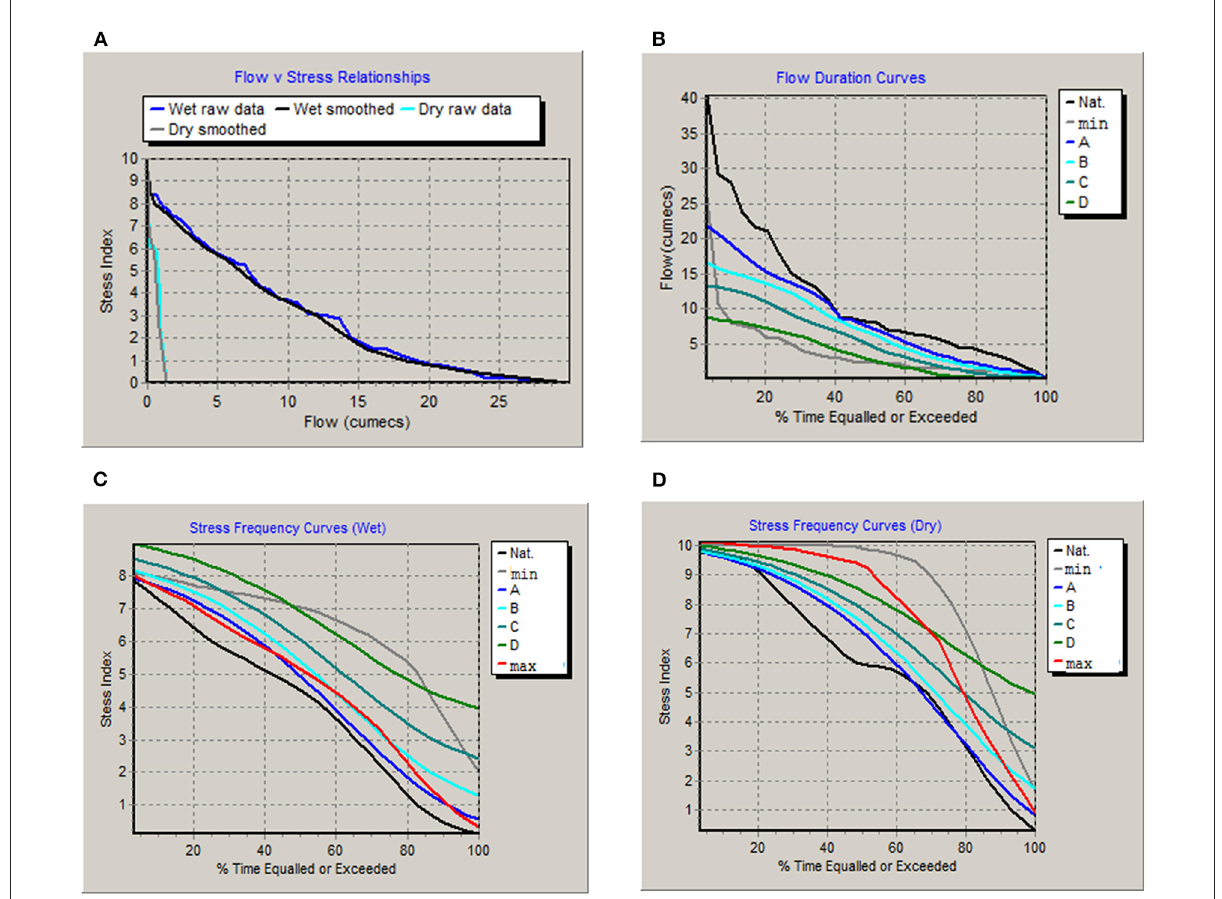
FIGURE6 Outputs of the ecology sub-model with RCP 8.5 minimum and maximum ensembles for upper Ecological Reserve site 5 (Ecological Category B) (A) flow vs. stress relationships and (B) flow duration curves for natural, minimum ensemble and the four Ecological Categories (C) stress frequency curves for wet and (D) dry